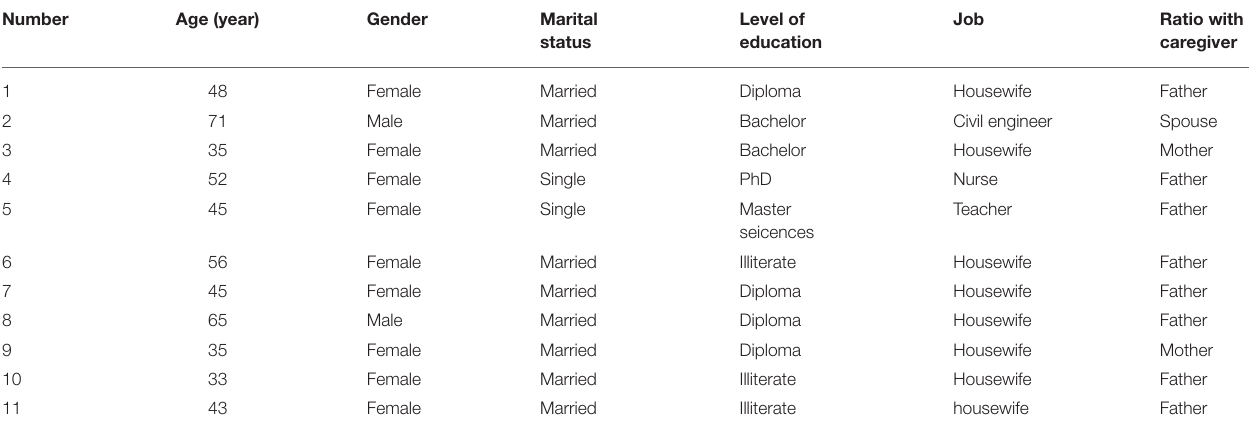
TABLE 2 | Demographic characteristics of the participants in the study.